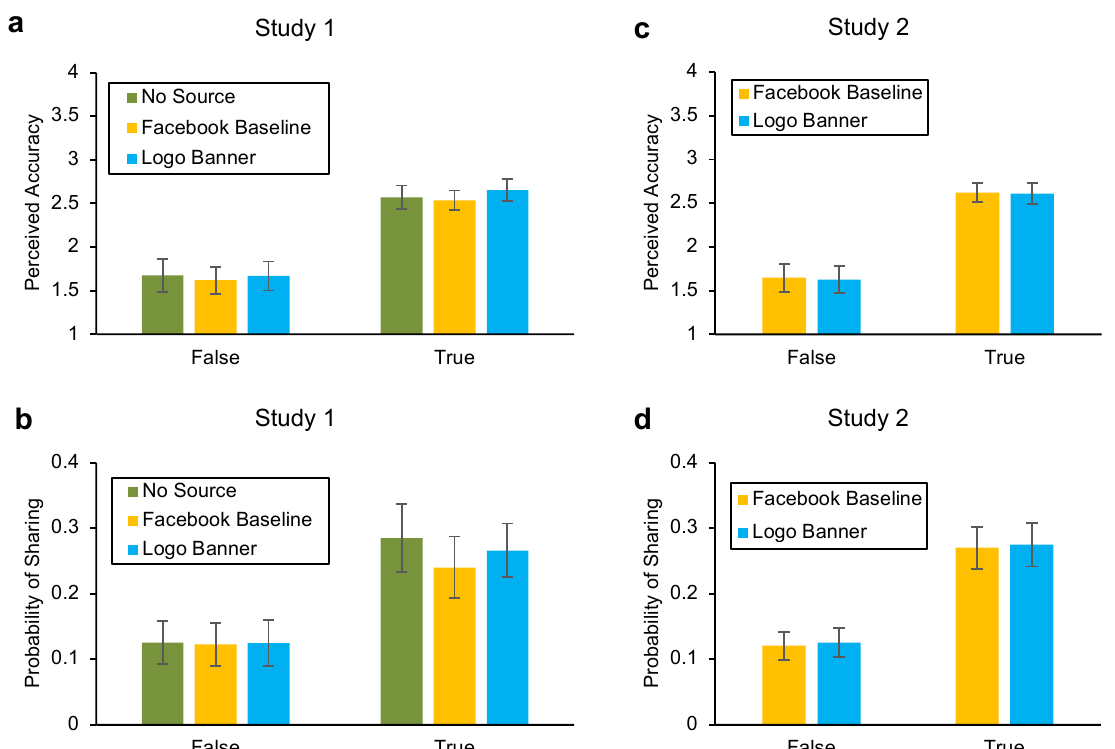
Figure 2. Varying source visibility did not affect accuracy perceptions or sharing intentions. Average reported accuracy (top row) and probability of sharing on social media (bottom row) for false versus true headlines across source visibility conditions in Study 1 (left columns) and Study 2 (right columns). Error bars indicate 95% confidence